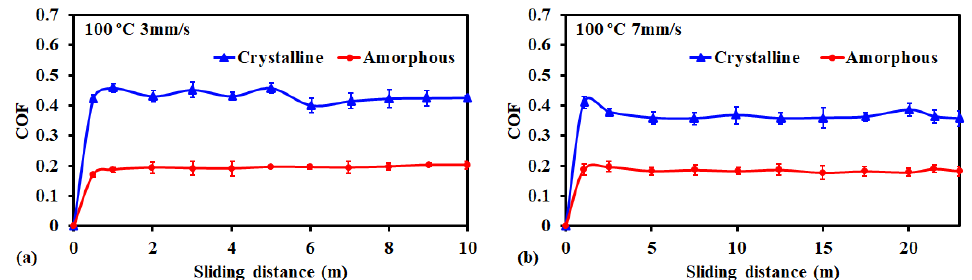
Figure 8. The measured coefficient of friction (COF) for crystalline Pd and amorphous Pd alloy samples with respect to sliding distance with the ionic liquid at 100 °C: ( a ) Sliding speed of 3 mm/s, ( b ) sliding speed of 7 mm/s.